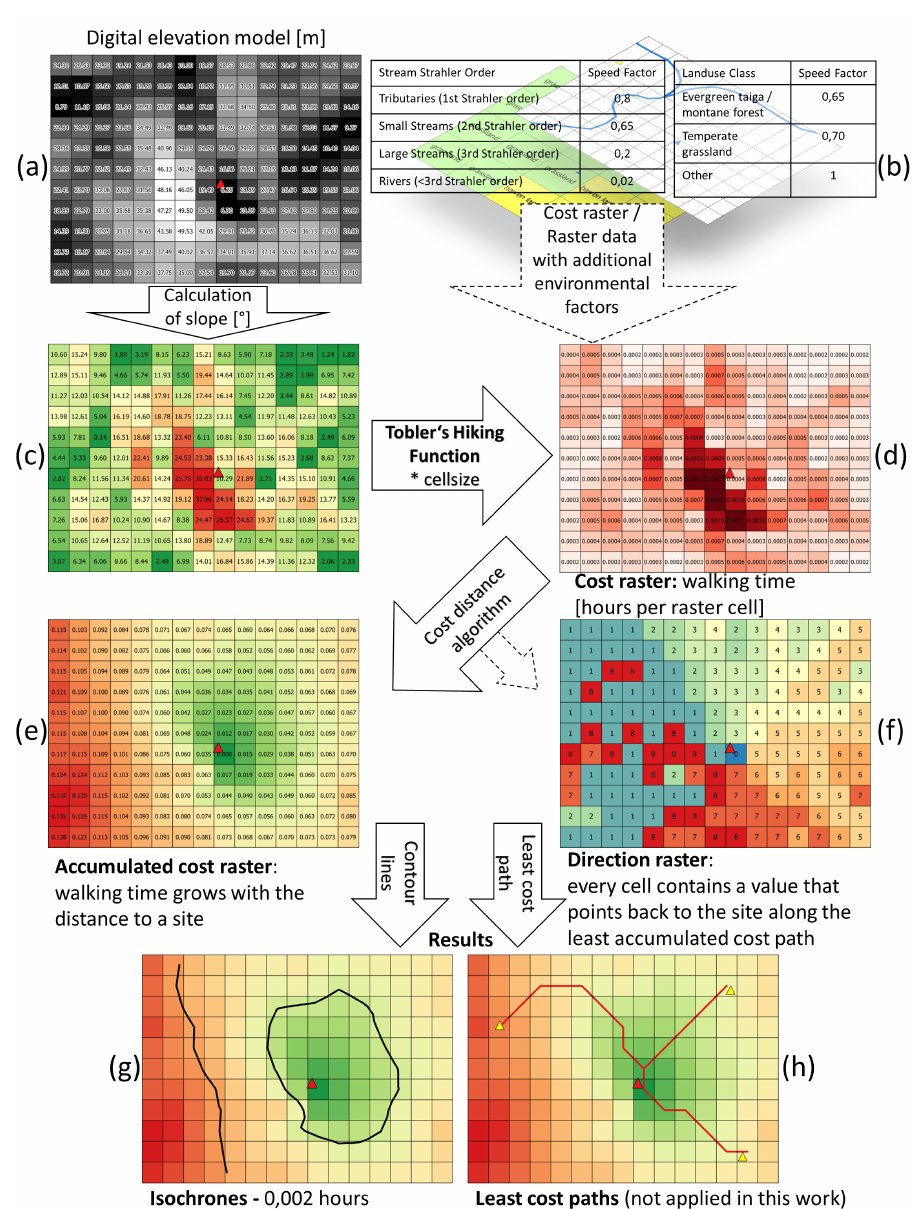
Figure 2. Process chart of the approach used to conduct the site catchment and least cost path modeling (LCP not applied in this